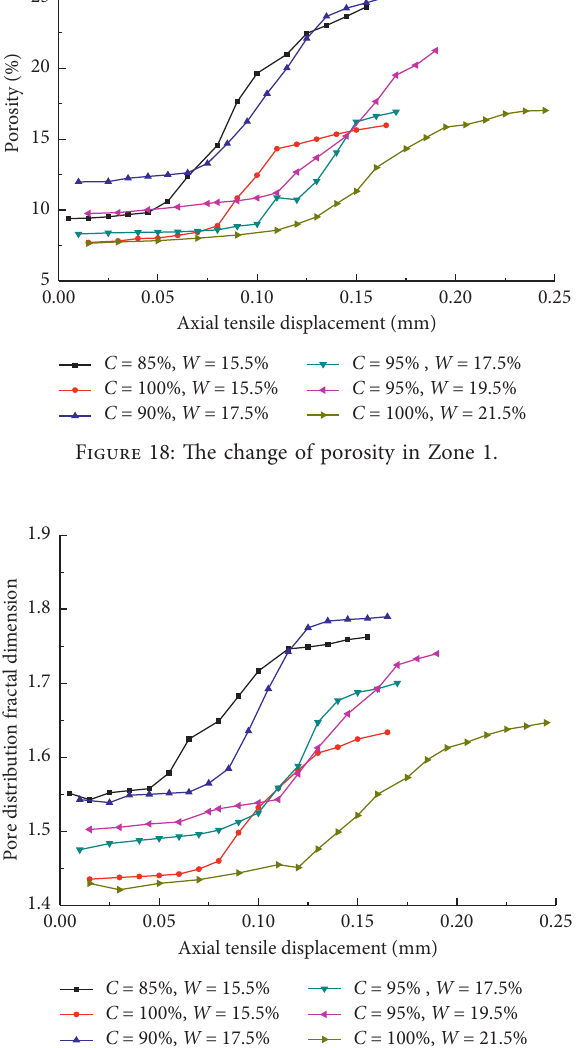
Figure 19: The change of pore distribution fractal dimension in Zone 1.